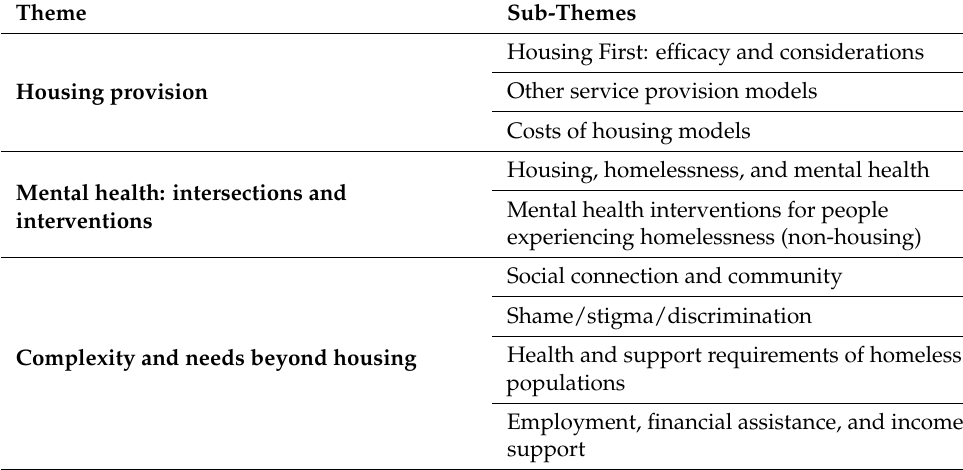
Table 7. Themes and